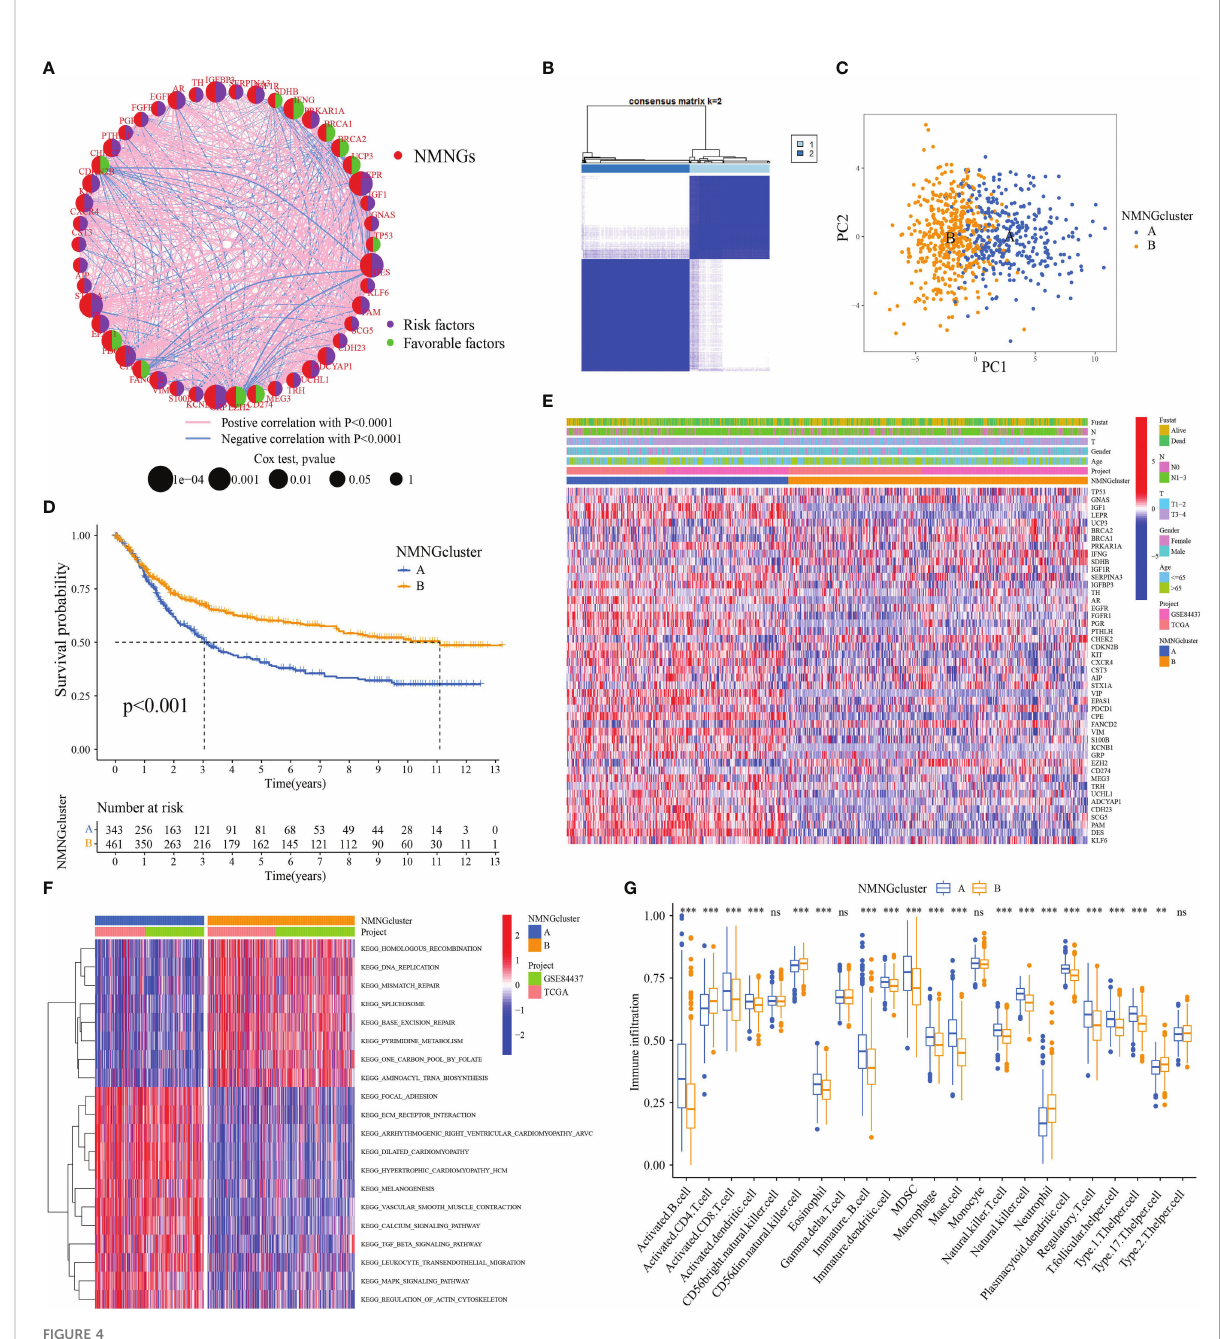
FIGURE 4 Patterns of NMNG modi fi cation and biological features of each pattern. (A) Mutual effects of NMNGs in STAD. (B) Unsupervised clustering analysis in STAD cohort. (C) Principal component analysis for two NMNG modi fi cation patterns. (D) Survival assay for the two NMNG modi fi cation patients. (E) Clinical characteristics of two NMNG modi fi cation patterns. (F) KEGG enrichment assay displaying the stimulation status of biological pathways of two NMNG modi fi cation patterns. (G) Expression of immune-in fi ltrating cells in two NMNG modi fi cation patterns. ** P<0.01, ***P<0.001; ns, not statistically signi fi